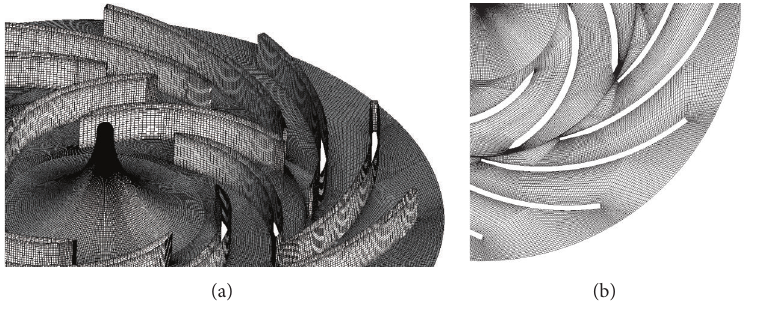
Figure 2: Computational